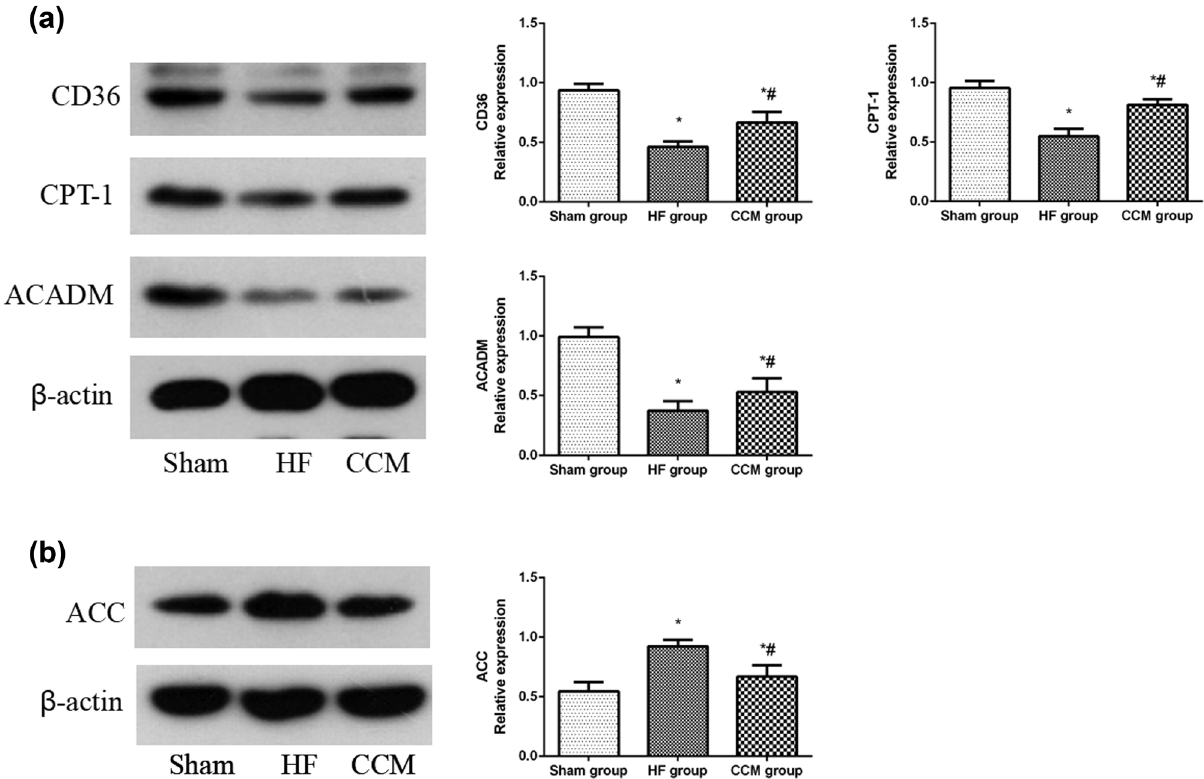
Figure 5: CCM treatment regulates the key fatty acid metabolism factors in rabbits with HF. ( a ) Western blot analysis of the expressions of CD36, CPT - 1, and ADAM. Densitometric analysis is shown in the bar graph. ( b ) Western blot analysis of the expression of ACC. Densitometric analysis is shown in the bar graph. Data are expressed as mean values ± SD ( * P < 0.05 compared with the sham group; # P < 0.05 compared with HF group ) .